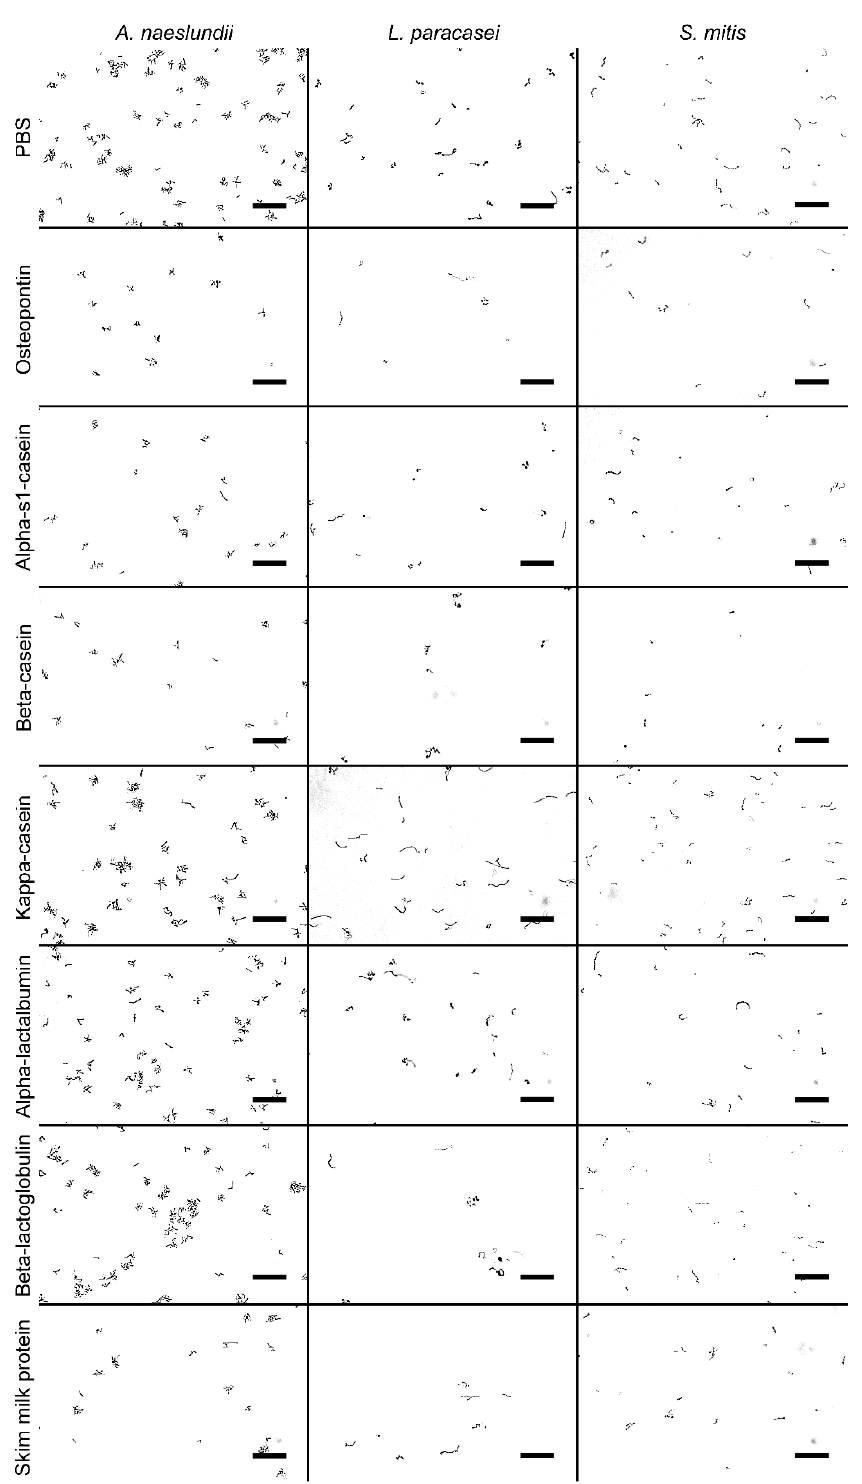
Figure 2. Representative bright field images of adherent bacterial cells. Only osteopontin and crude skim milk protein were able to significantly reduce the attachment of all three bacterial species. PBS = phosphate buffered saline. Bars = 20 µm.